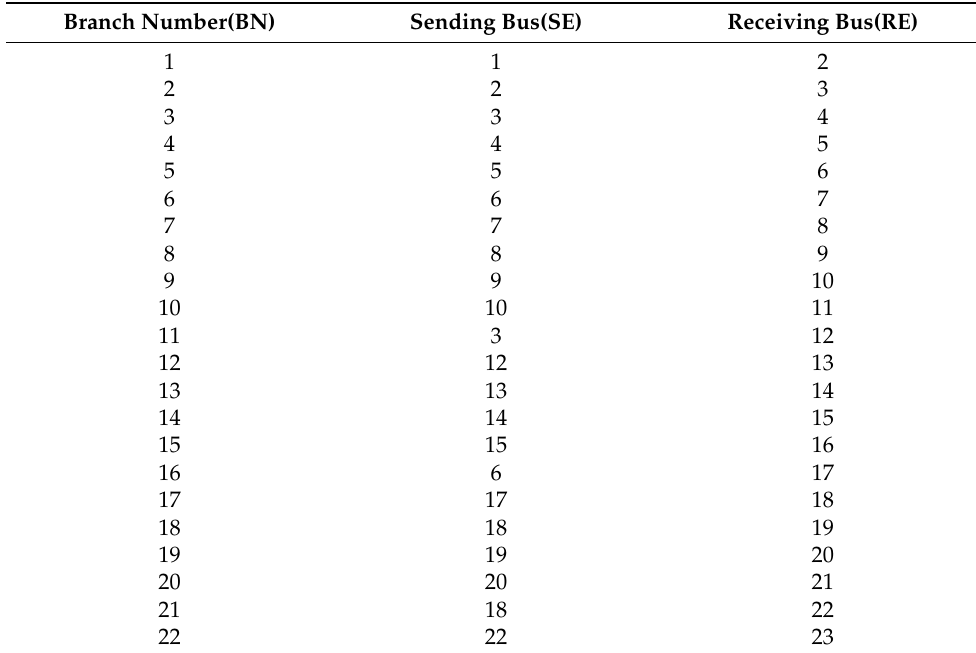
Table 3. Branch numbering of distribution network in Figure